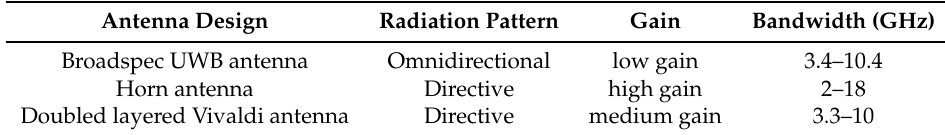
Table 1. Antennas tested and compared in